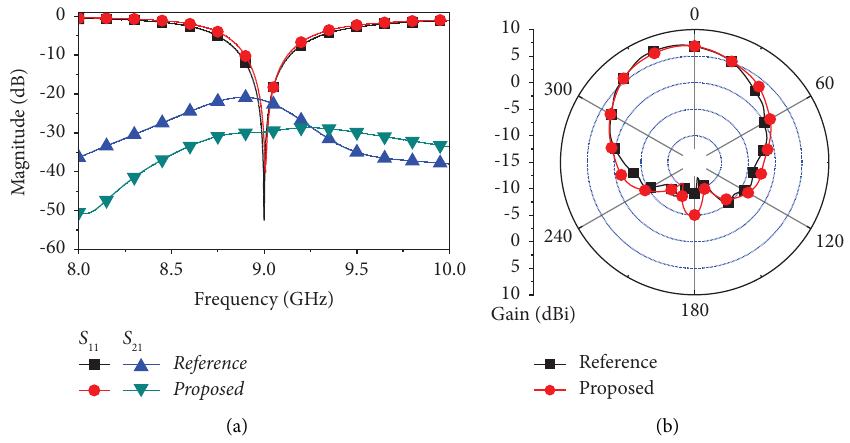
Figure 5: Simulated scattering parameters. (a) S